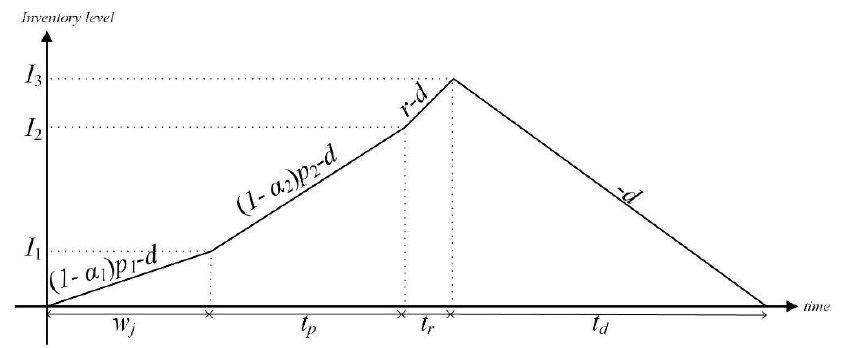
Figure 2. The inventory level of the first model, including reworked items.